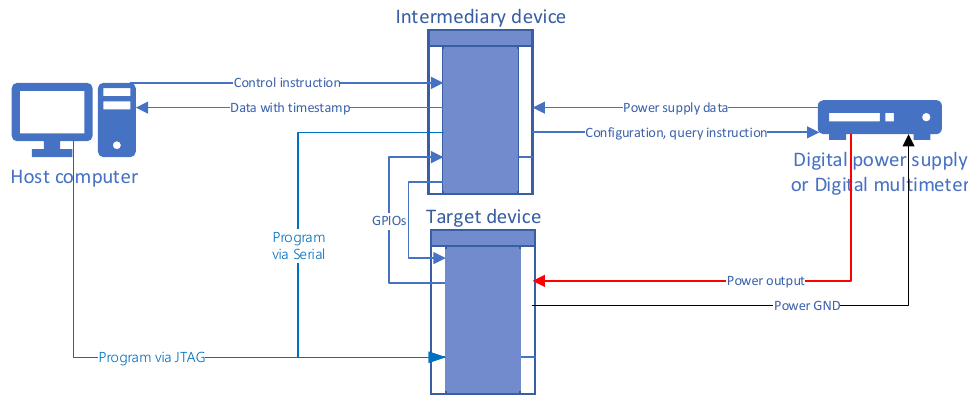
Figure 4. The architecture and wiring of the standalone design.